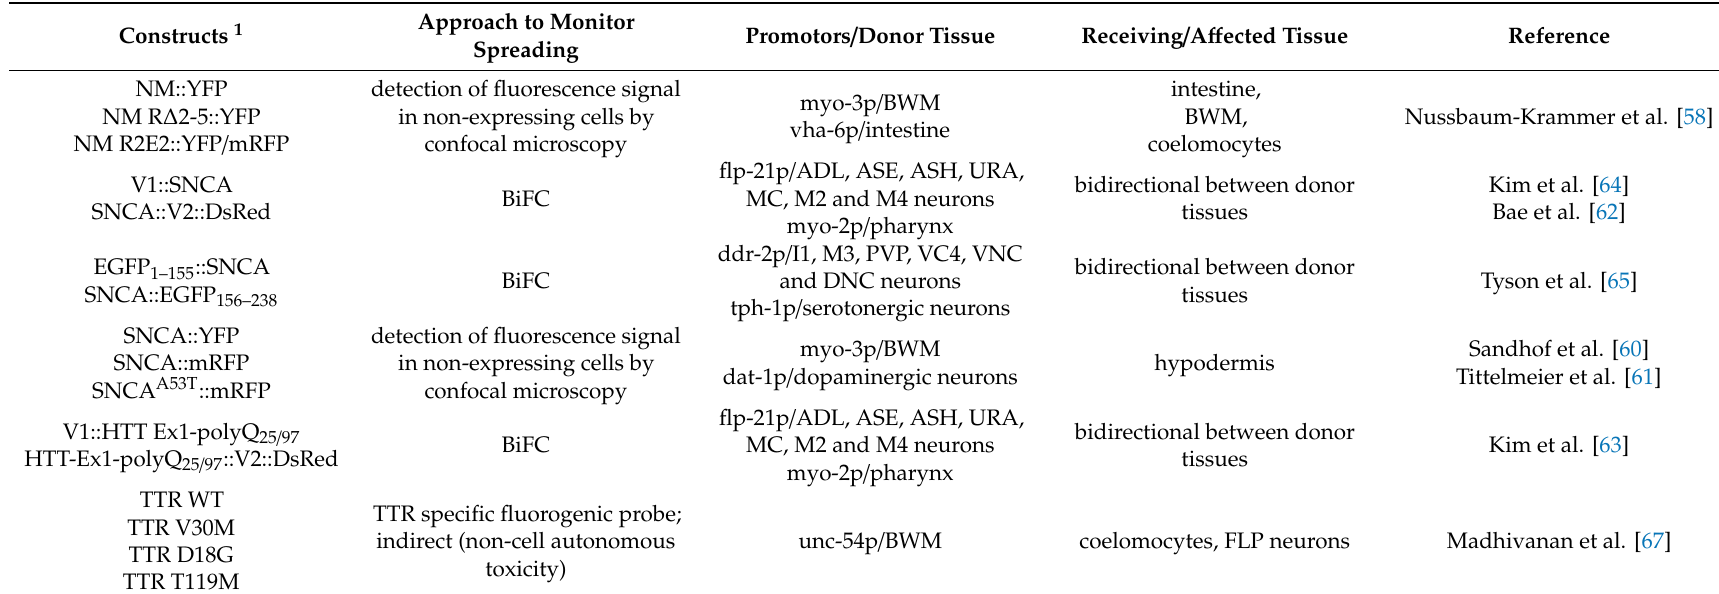
Table 1. C. elegans models to investigate prion-like